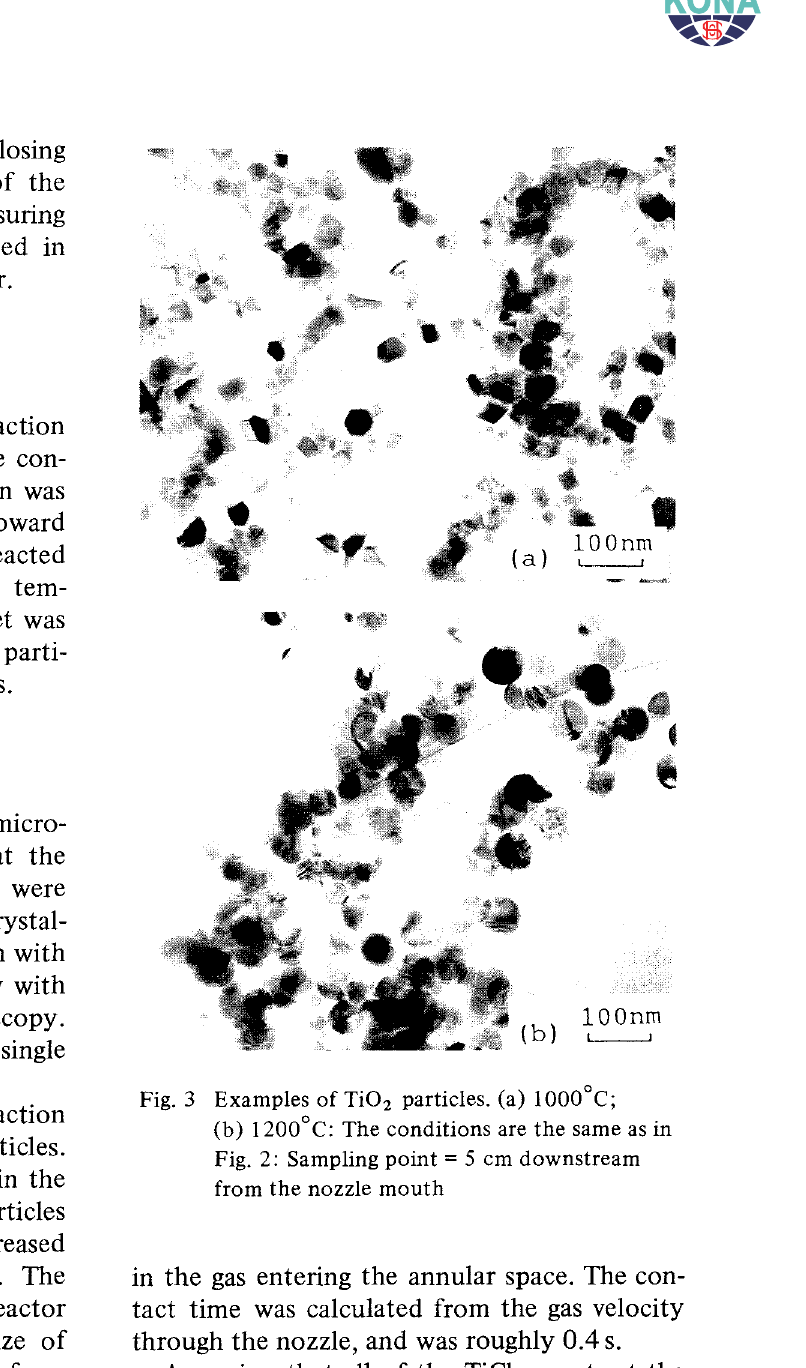
Fig. 3 Examples of Ti0 2 particles. (a) 1000°C; (b) 1200°C: The conditions are the same as in Fig. 2: Sampling point= 5 em downstream from the nozzle